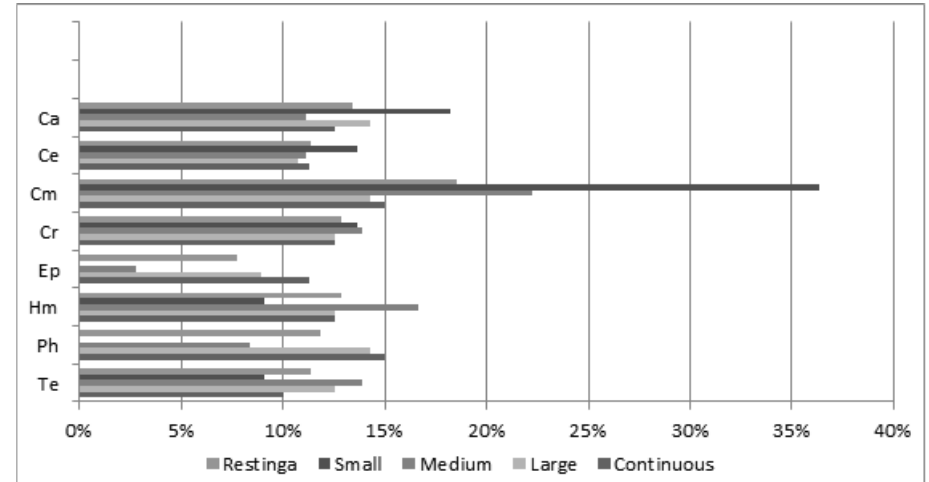
Fig 2 . Spectrum of plant life forms found in Parque das Dunas. Ca = Cactaceae, Ce = Creepers, Cm = Chamephytes, Cr = Cryptophytes, Ep = Epiphytes, Ph = Phanerophytes, Hm = Hemicryptophytes, Te =